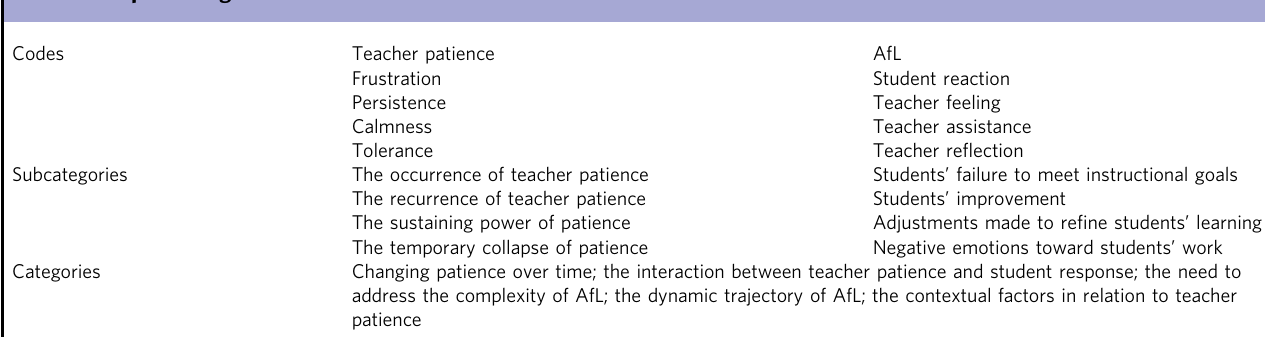
Table 1 Sample coding scheme.